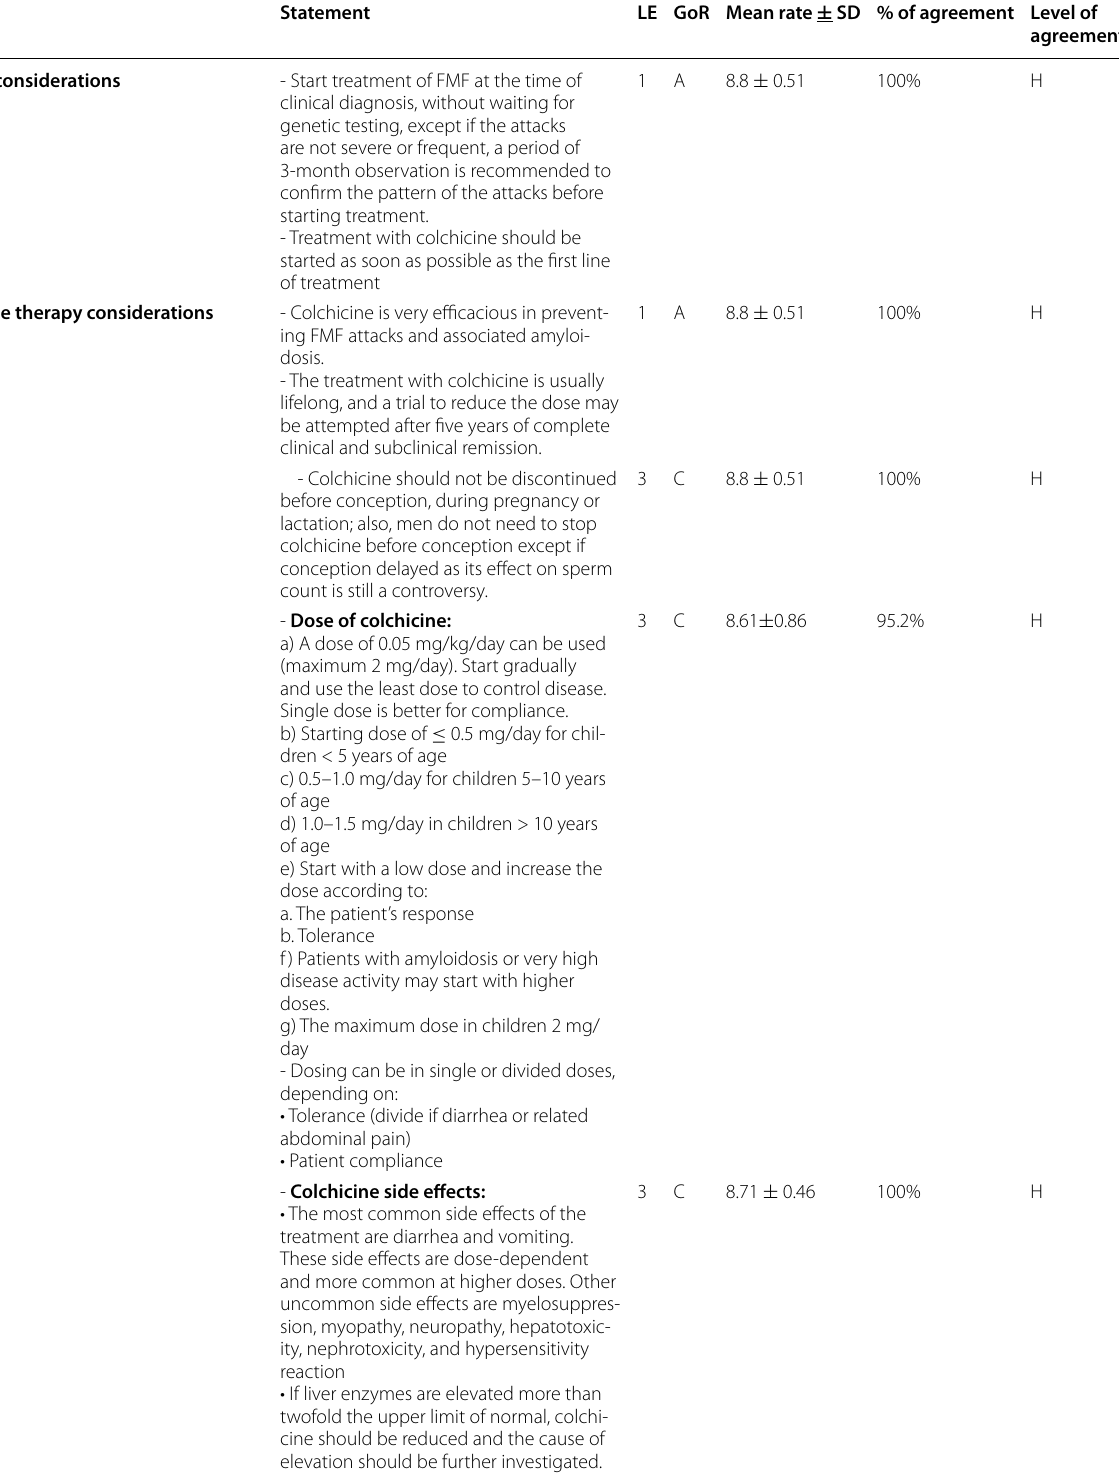
Table 5 Summary of recommendations of FMF management Standard General considerations